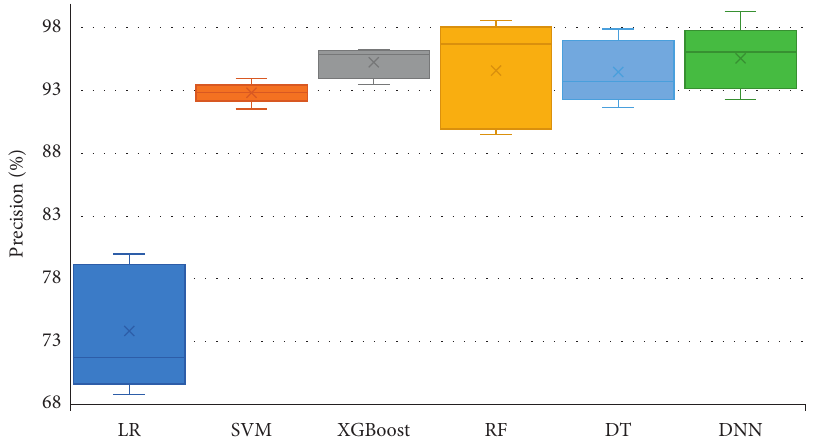
Figure 12: Performance comparison of classifiers based on precision.